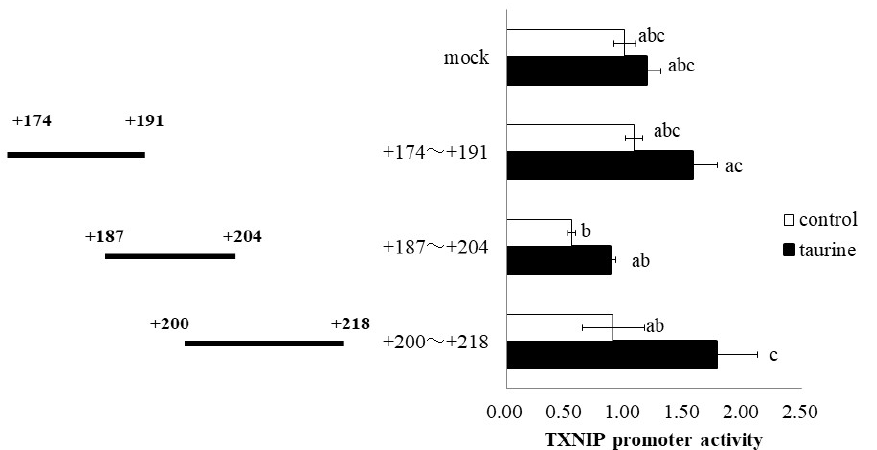
Figure 4. Effect of taurine on the transcriptional activity of the TXNIP promoter between +174/+218. Caco-2 cells were transfected with a reporter vector containing partial promoter regions of TXNIP (+174/+191, +187/+204, +200/+218) and then replaced with a medium containing 100 mM of taurine. After 24 h, the cells were subjected to a luciferase assay. The results are expressed as relative values, with the control value as 1. Each value is the mean ± S.E. ( n = 3) and the abc values indicated by different characters are significantly different from each other, and the abc values indicated by the same characters are not significantly different (Tukey’s test; p < 0.05).